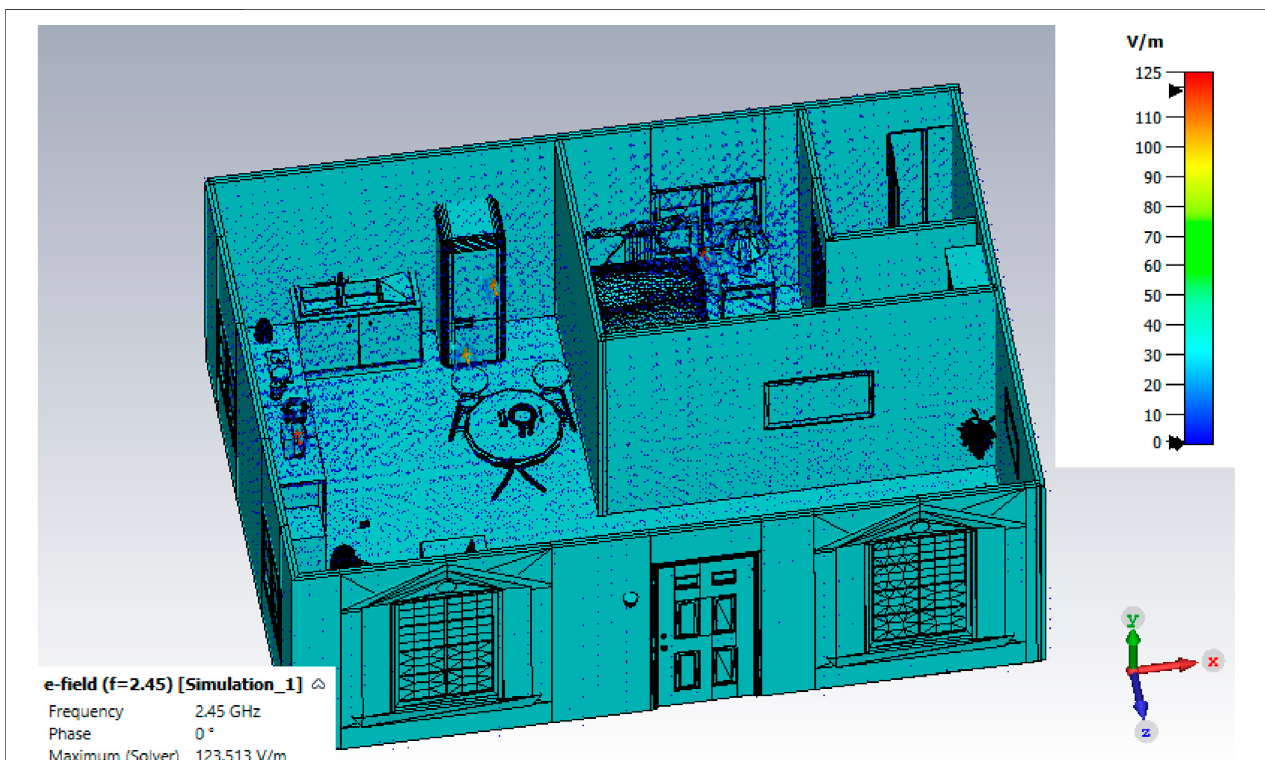
FIGURE 8 | Electric fi eld distribution for hybrid design (5 wireless and 7 wired).